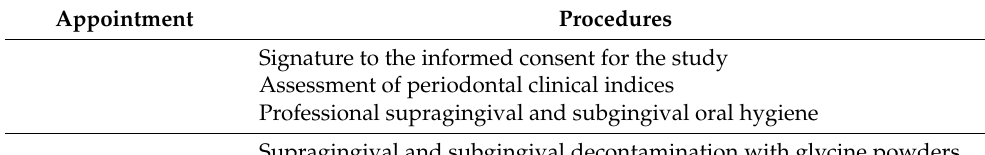
Table 8. Protocol adopted for the